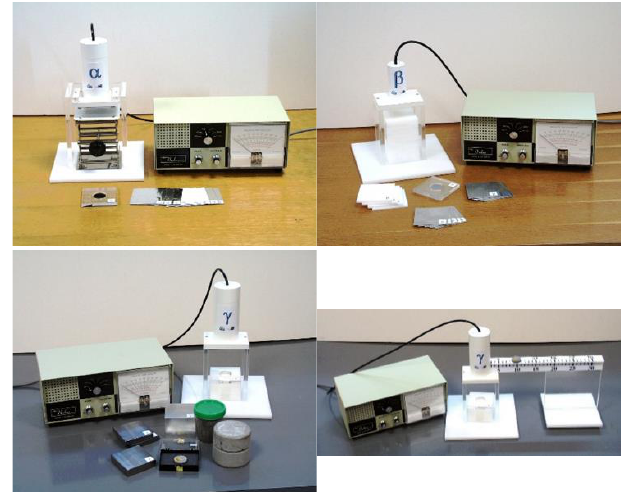
Fig. 7. Equipment for demonstration of radiation